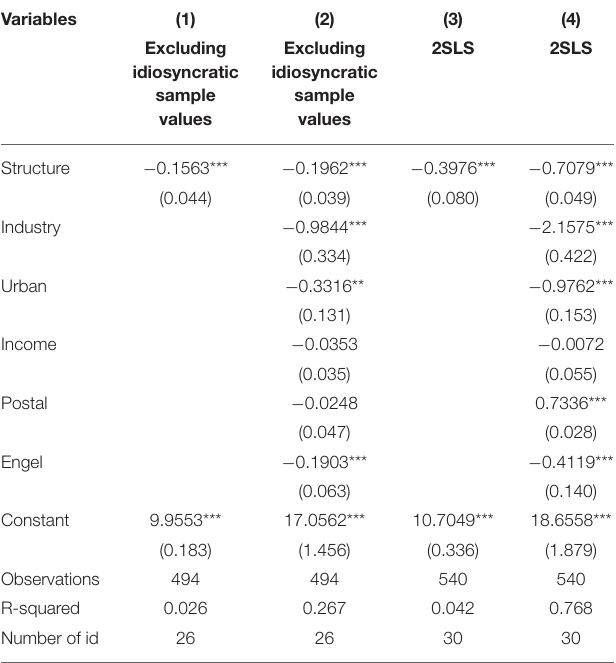
TABLE 7 | Robustness test